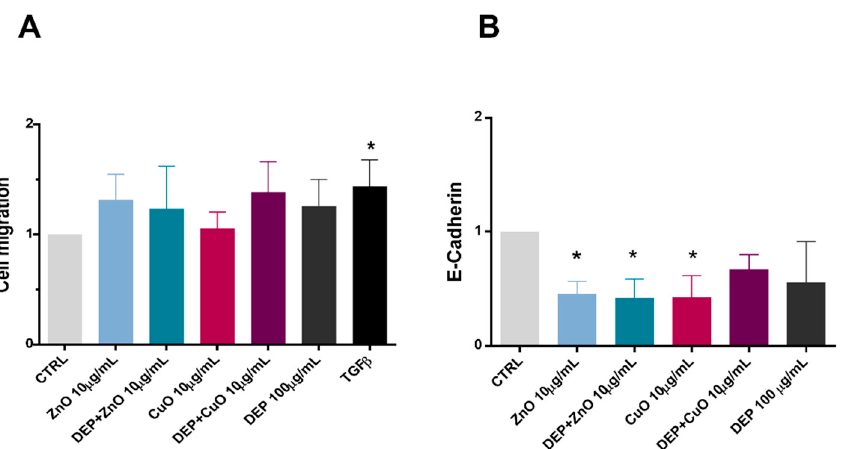
Figure 3. Cell migration and E-cadherin expression. ( A ) Cell migration was evaluated in cells exposed to 10 µ g/mL of ZnO and CuO, and respective mixtures with DEPs (100 µ g/mL), compared with untreated cells (CTRL) and with a positive control for migration (TGF- β ) (data are presented as fold change with respect to the control). ( B ) At the same exposure concentration, the expression of E-cadherin (presented as fold change with respect to the control) was evaluated by cytofluorimeter. Data represent the mean ± SE of three independent experiments ( n = 3). *: Statistically different with respect to control samples; p < 0.05, one-way ANOVA and Bonferroni’s post-hoc test.